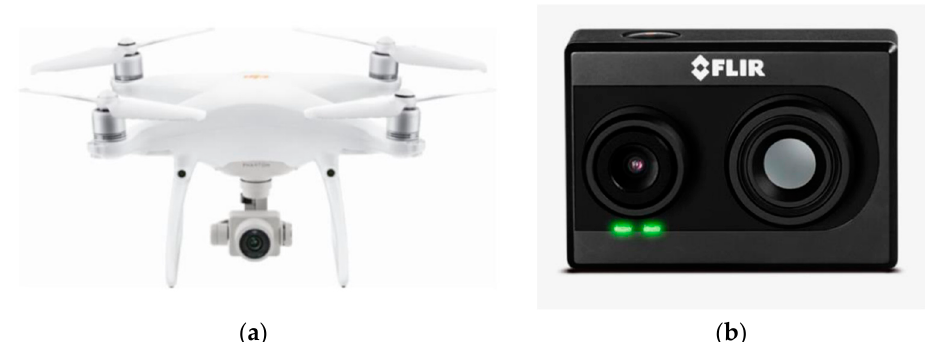
Figure 2. Photos of instruments: ( a ) is DJI Phantom 4 Quadcopter and ( b ) is the FLIR DUO R dual-sensor thermal camera.